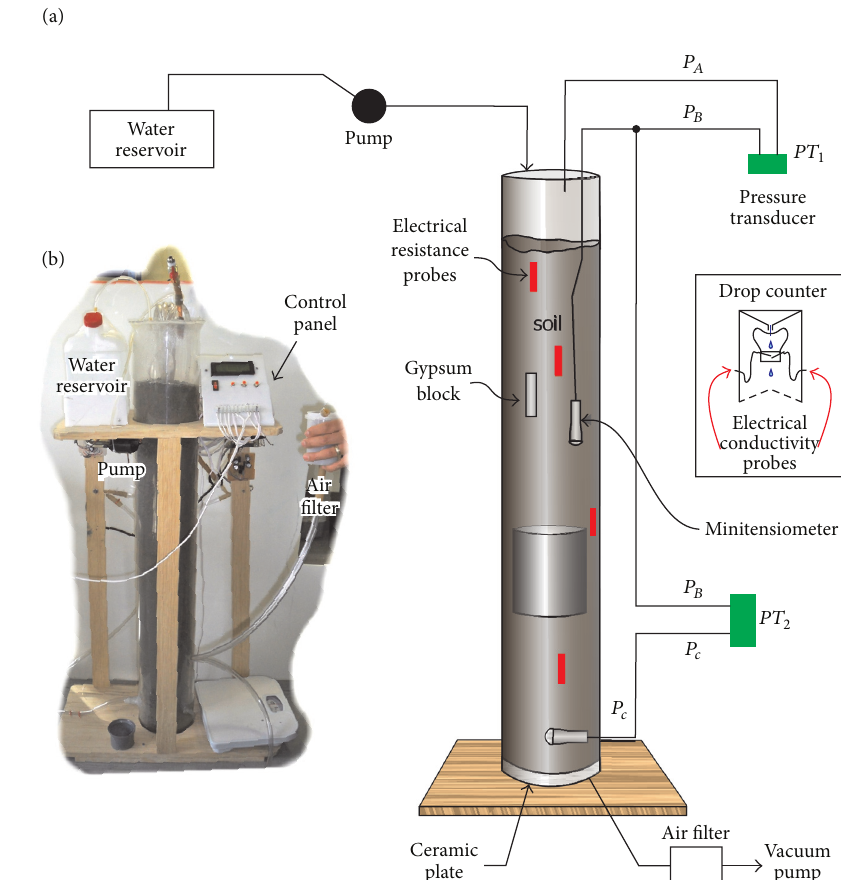
Figure 1: (a) Schematic representation of the experimental design of the automated test column (ATC) and (b) photograph showing the external components used for drainage